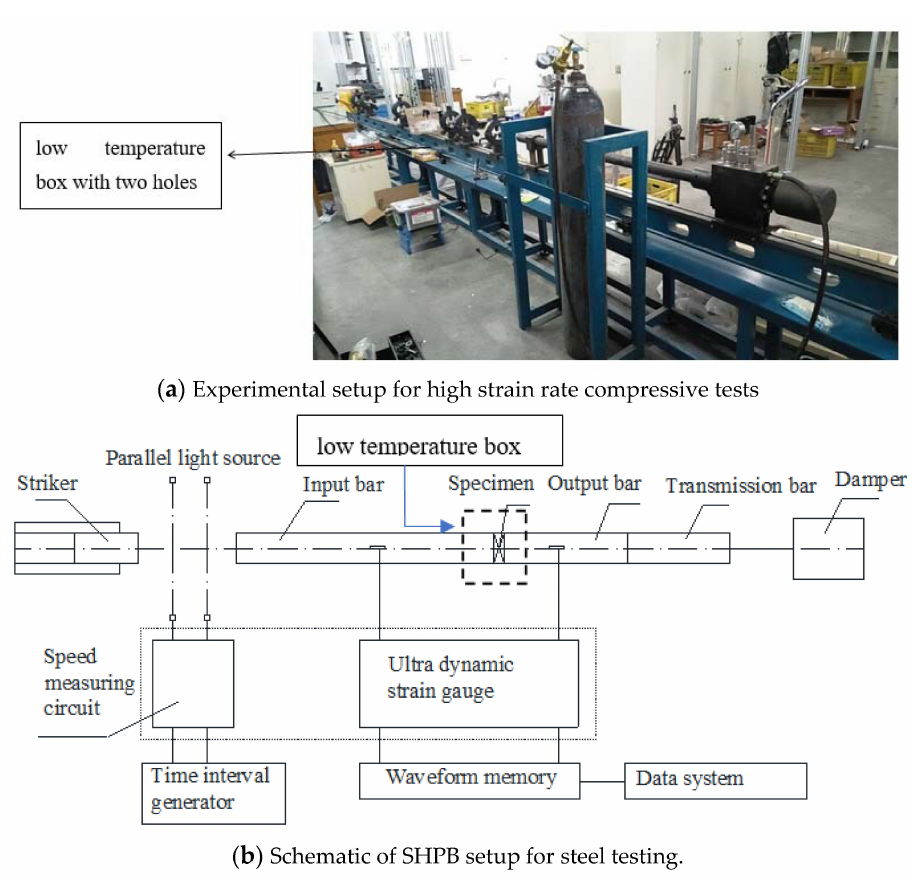
Figure 4. Setup of Split Hopkinson Pressure Bar (SHPB) test